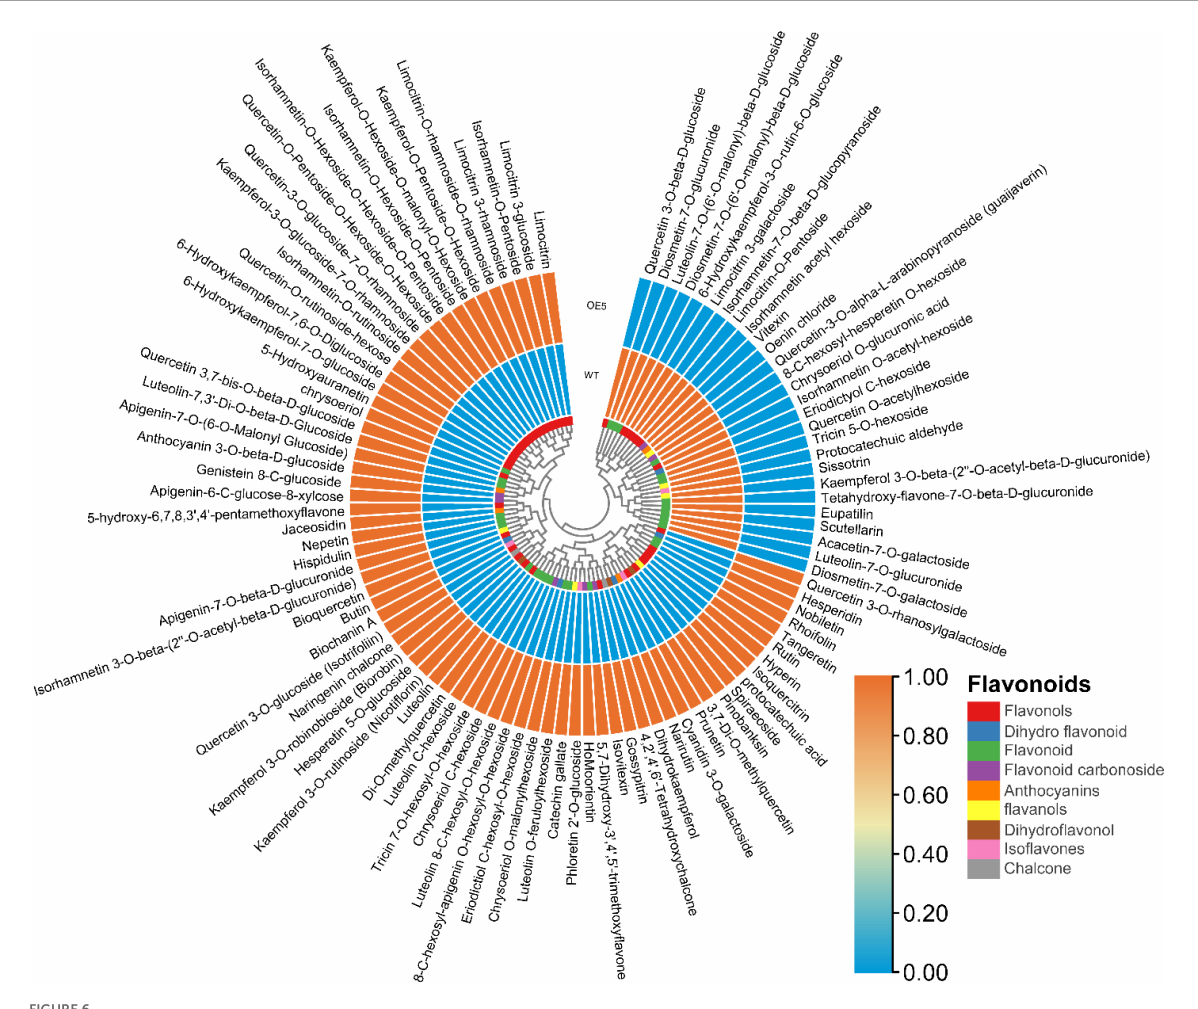
FIGURE6 The cluster heat map of flavonoid metabolites between WT and